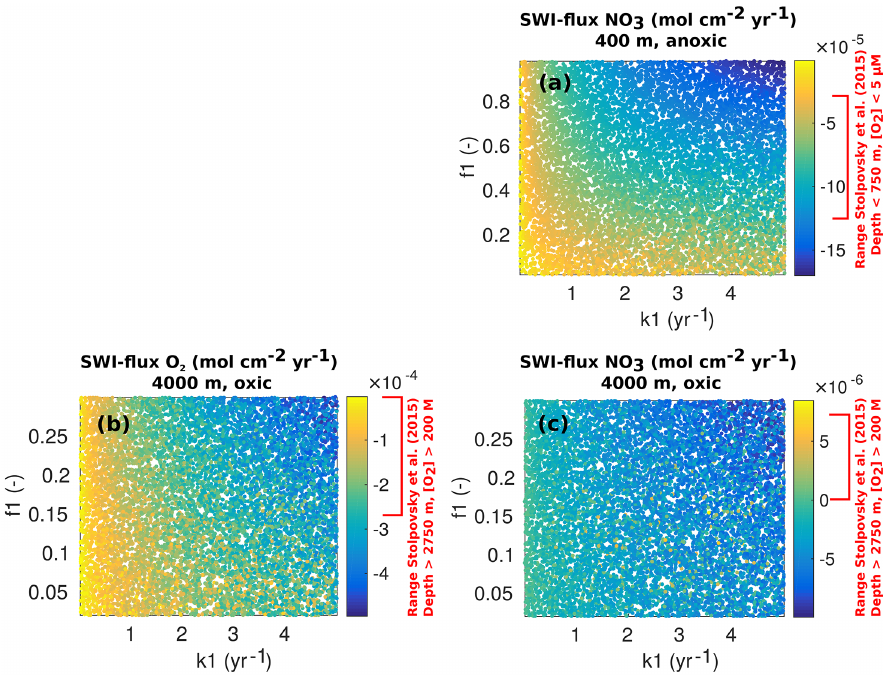
Figure 6. Scatter plots ( k 1 vs f 1 ) of resulting OMEN-SED SWI fluxes for the 400m anoxic ( a : NO 3 ) and 4000m oxic ( b : O 2 , c : NO 3 ) scenario. Negative values represent a flux from the water column into the sediments. Ranges indicated in red on the colour scale correspond to observed benthic fluxes as reported in the global database of Stolpovsky et al. (2015). Table 13. Boundary conditions for simulated sediment profiles at the Iberian margin (108 and 2213m), the Santa Barbara Basin (585m) and the Nazaré Canyon (4298m) reported in Fig. 7. For all sites a DIC bottom water concentration of 2400nmolscm − 3 is assumed. Sediment characteristics Depth Temp. z bio D bio POC 1 POC 2 k 1 k 2 PO a (m) ( ◦ C)